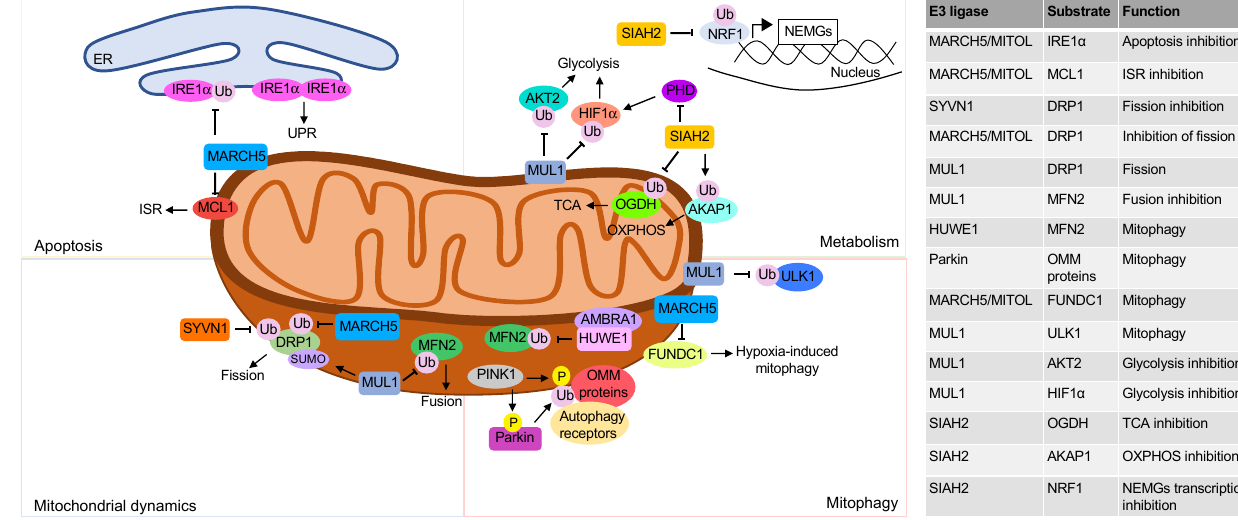
Figure 1. Mitochondrial regulation by UPS. The top left panel describes the ubiquitination events involving mitochondria E3 ligases that regulate apoptosis. The mitochondria E3 ligase MARCH5 ubiquitinates IRE1 α located at the mitochondria associated membranes (MAMs) and inhibits apoptosis. Activation of ISR by anti-tumor drugs in solid tumors induces MARCH5-mediated ubiquitination and proteolysis of the antiapoptotic protein MCL1. The bottom left panel shows how the UPS regulates mitochondria dynamics, principally through post-translation modifications of DRP1 and MFN2. DRP1 sumoylation by MUL1 stabilizes the protein and promotes mitochondrial fission. Ubiquitin-dependent proteolysis of DRP1 by MARCH5 and SYVN1 inhibits mitochondrial fission. Moreover, the E3 ligase MUL1 by ubiquitinating and degrading MFN2 inhibits mitochondrial fusion. The top right panel describes ubiquitination events that regulate mitochondrial metabolism. The mitochondrial E3 ligase MUL1 ubiquitinates and degrades the cytoplasmatic proteins AKT2 and HIF1 α rewiring cellular metabolism. The E3 ligase SIAH2 ubiquitinates and degrades the OGDH subunit of α ketoglutarate dehydrogenase, switching the glutamine metabolism to fatty acid syn- thesis. Moreover SIAH2, under hypoxia conditions, ubiquitinates and degrades AKAP1, reducing oxidative phosphorylation. Finally, SIAH2 ubiquitinates the transcription factor NRF1 and inhibits the transcription of the nuclear encoded mitochondrial genes (NEMGs). The bottom right panel shows how UPS at mitochondrial compartment regulates mitophagy. In response to mitochondrial damage, PINK1 accumulates at the OMM, phosphorylates ubiquitin, and recruits and activates Parkin. Parkin ubiquitinates different proteins at the outer mitochondrial membrane that are, then, recognized by autophagy receptors that promote mitophagy. Following oxidative stress, AMBRA1 recruits the E3 ligase HUWE1 at OMM. Here, HUWE1 ubiquitinates and degrades MFN2, favoring the elimination of damaged mitochondria. The mitochondrial E3 ligase MUL1 ubiquitinates ULK1 and promotes mitophagy. MARCH5 binds to- and ubiquitinates FUNDC1, promoting its proteasomal degradation. Downregulation of FUNDC1 regulates hypoxia-induced